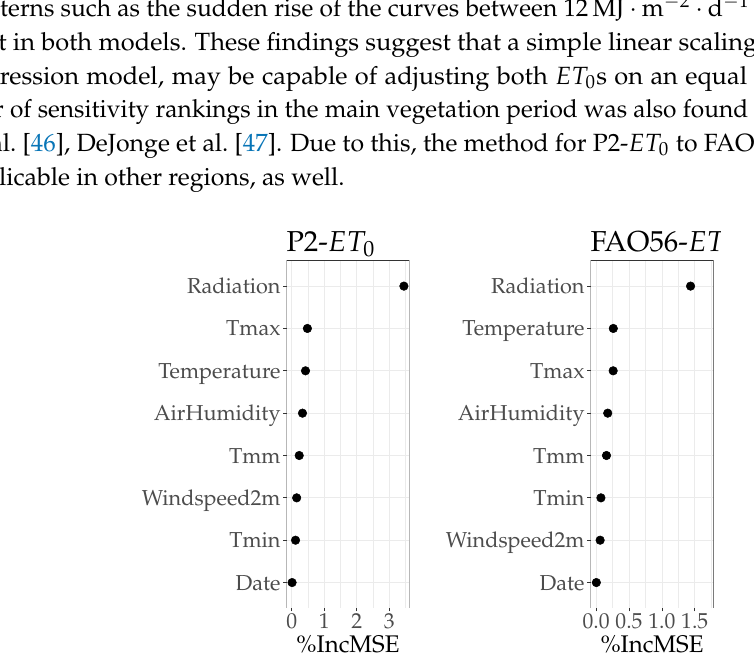
Figure 2. Residuals (mm d − 1 ) versus predicted (mm d − 1 ) plot of the regression model P2- ET 0 · · ˆ P 2- ET ˆ P 2- ET P2- ET 0 0 versus 0 . With the null line (black), residual mean (red line), and polynomial − trend line of residuals (blue line, y = 1.07 0.82 0.04, α = 0.01, adj . R 2 = 0.03). x 2 x · − · −